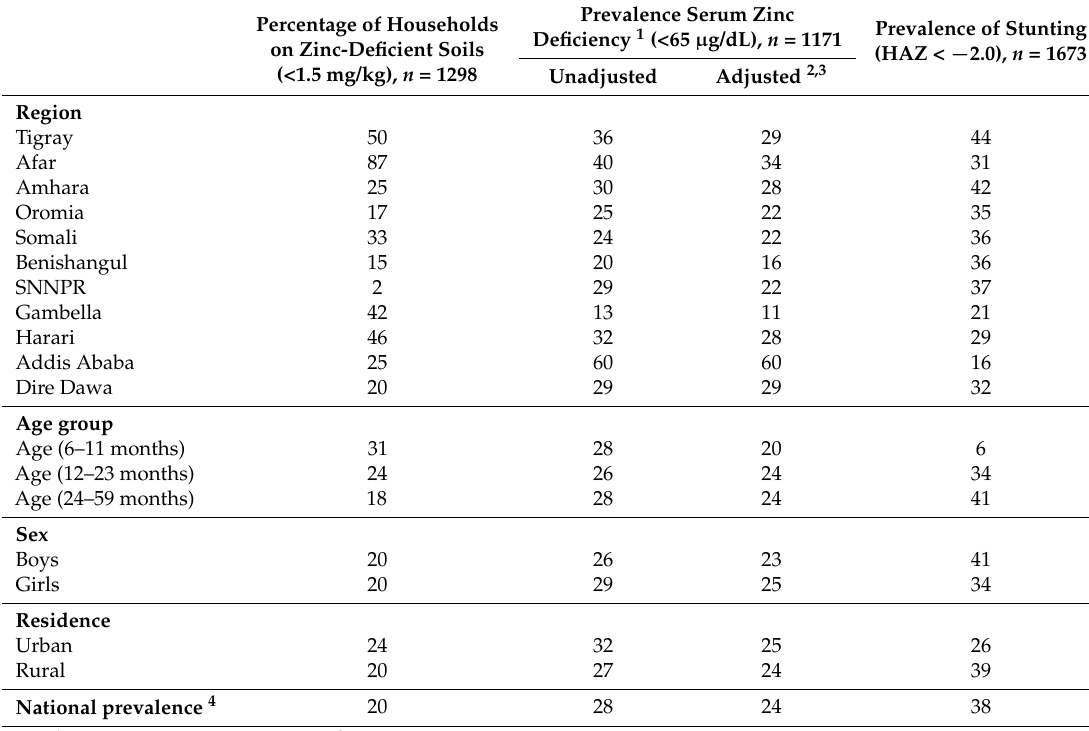
Table 2. Prevalence and geographical distribution of soil zinc deficiency, child serum zinc deficiency and child stunting in Ethiopia by